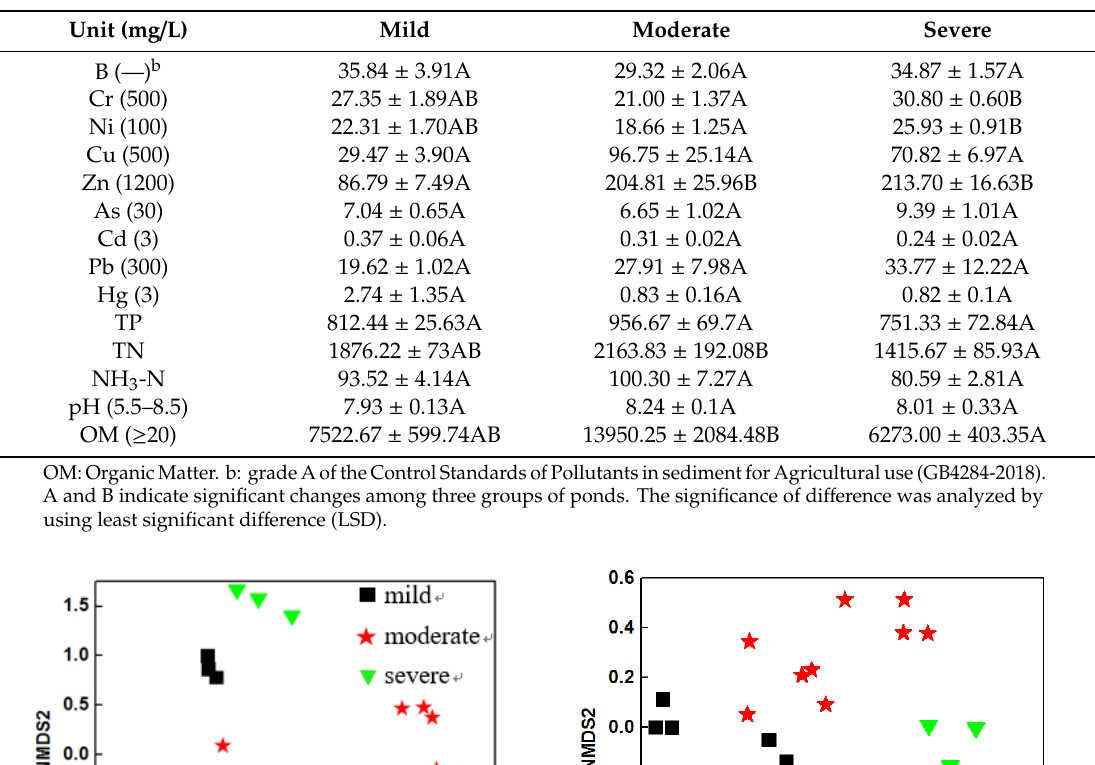
Table 3. Physical and chemical properties in sediment samples.